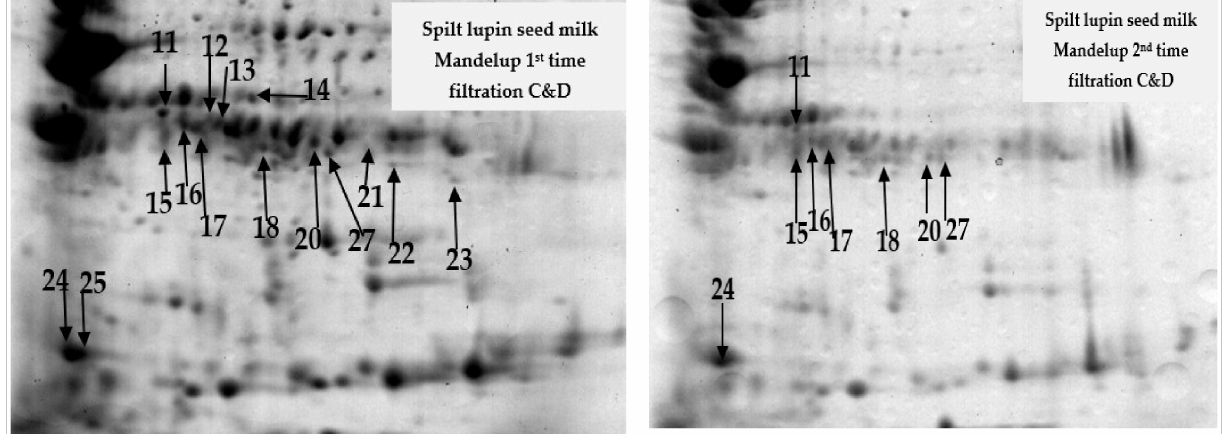
Figure 3. Comparison of the respective regions of the two-dimensional gel demonstrating the expression of differentiating proteins between the two cultivars examined. The letters A–C indicate the regions displayed in Figure